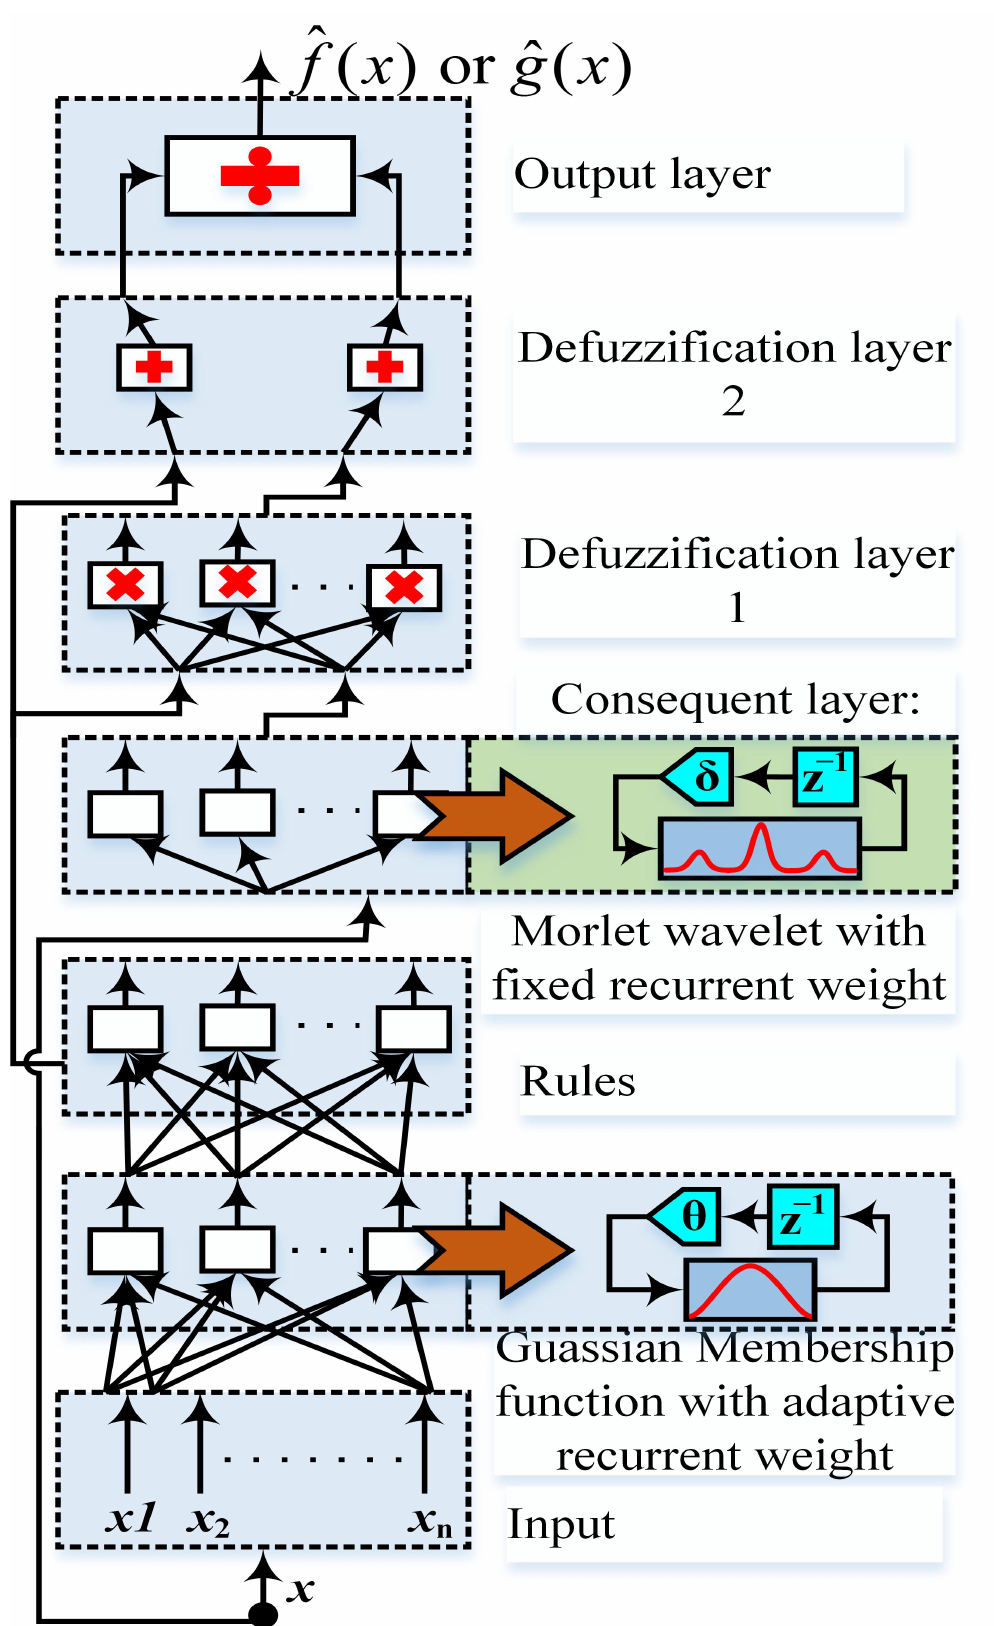
Figure 9. Gaussian membership function with Morlet